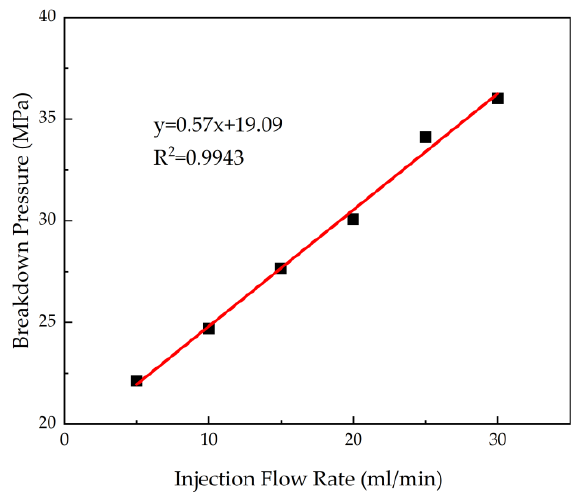
Figure 12. Influence of injection flow rate on the breakdown pressure.